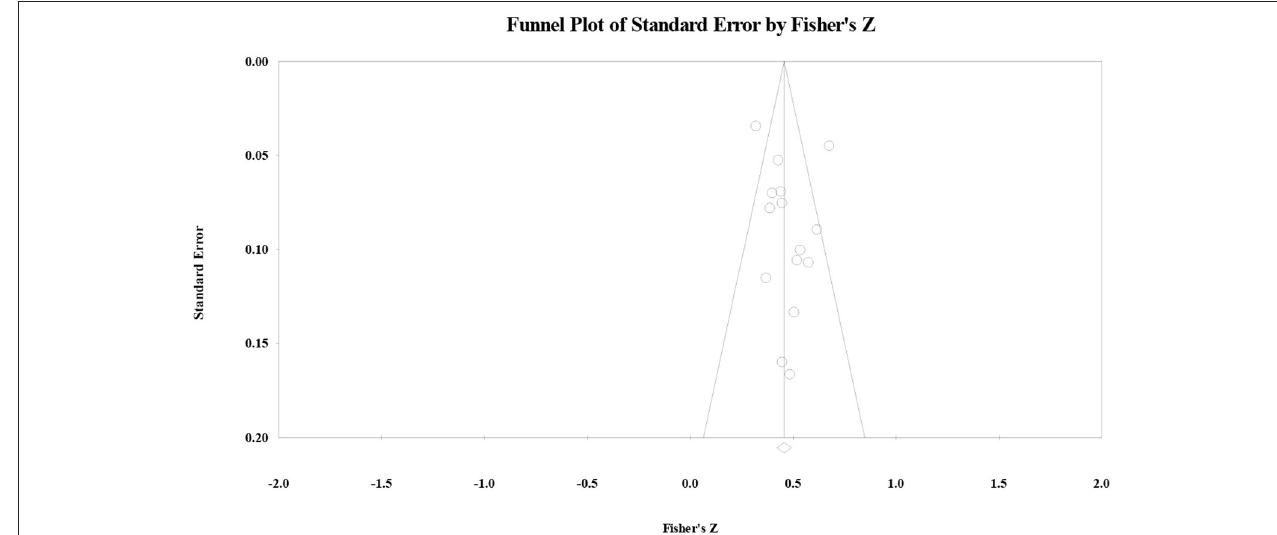
FIGURE 3 | Funnel plot of the correlation between the monitoring strategy and reading comprehension.